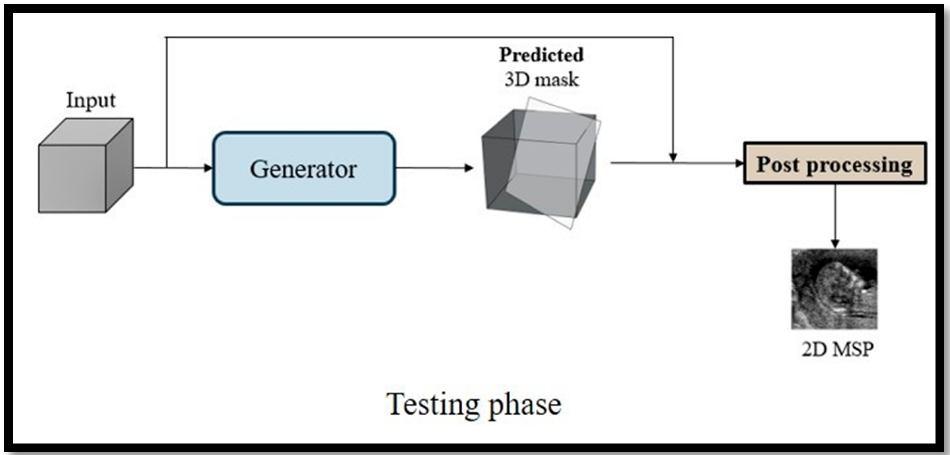
Figure 3. Training phase.